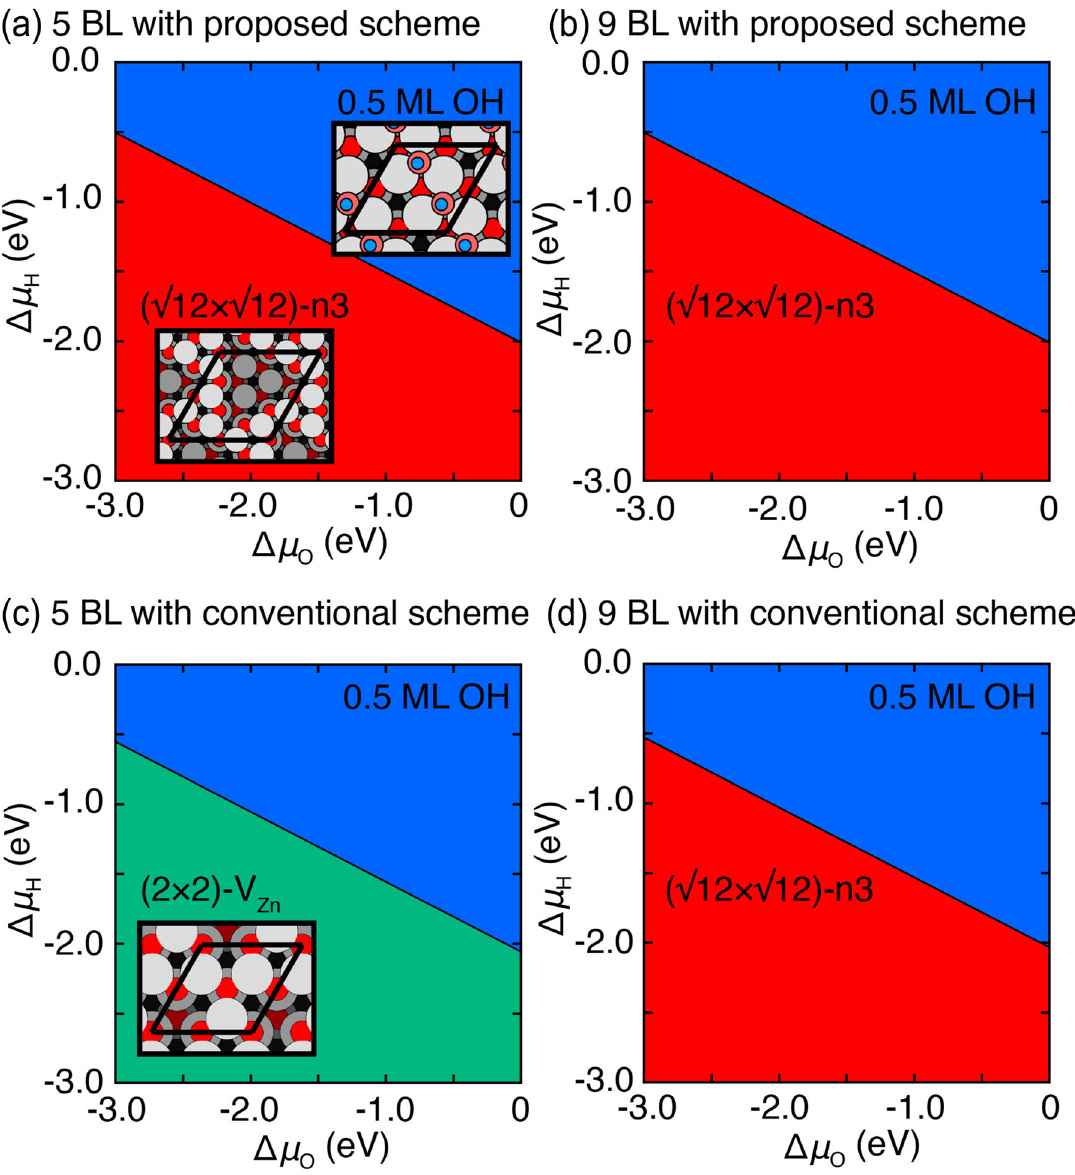
phases: 0.5 ML OH adsorbed on a bulk-terminated surface (blue), a Zn vacancy in a (2 × 2) unit cell (green), and a triangular reconstruction ffiffiffiffiffi p ffiffiffiffiffi p ð ´ Þ (cid:2) n 3 in which 6 Zn atoms and 3 O atoms are removed from the fi rst two surface layers (red). The respective surface structures 12 12 (top view) are shown as insets with O, Zn, and H atoms shown as red, white, and blue